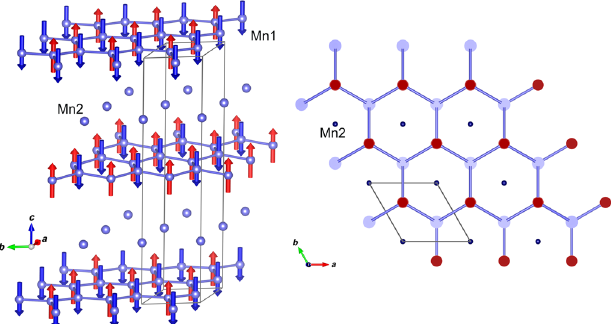
FIG. 8. Magnetic structure for the temperature range 3 K ≤ T ≤ 85 K defined by a Ne´el-type antiferromagnetic arrangement of Mn1 moments in the honeycomb layer, while the Mn2 in triangular layers remains paramagnetic. The ordered moments are aligned along the c direction. The successive antiferromagnetic planes are stacked ferromagnetically. The right panel displays a projection of the structure along the c axis, emphasizing the location of paramagnetic Mn2 site on top or underneath the zero molecular field created by the six surrounding Mn1 ordered